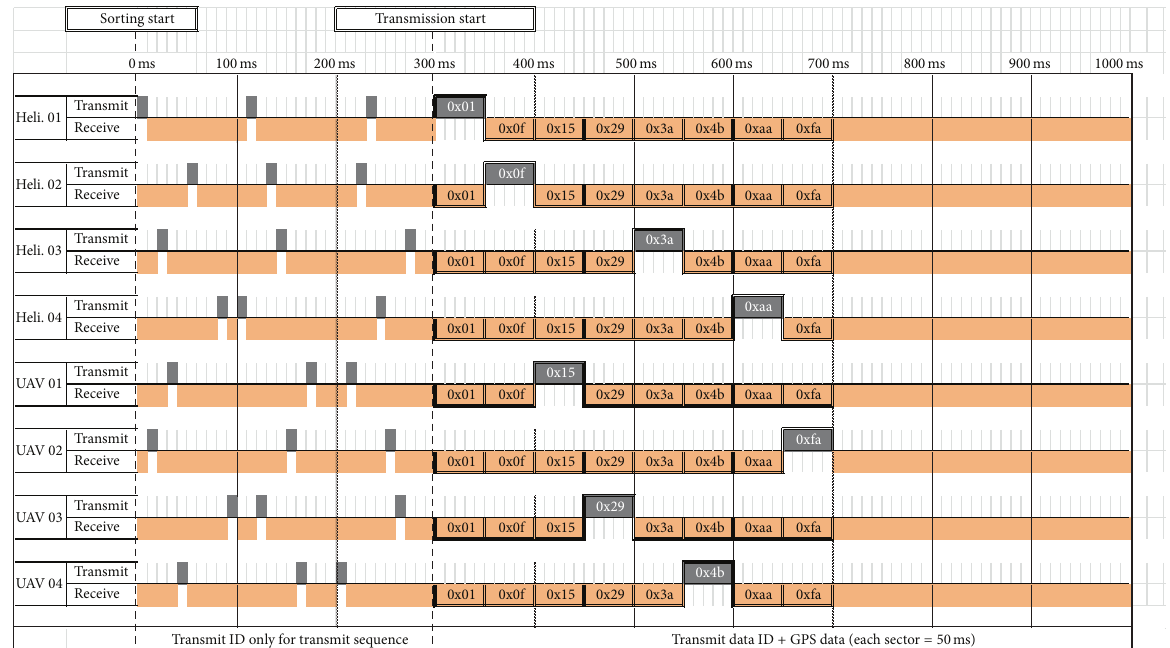
Figure 2: An example of 8-aircraft transmission time